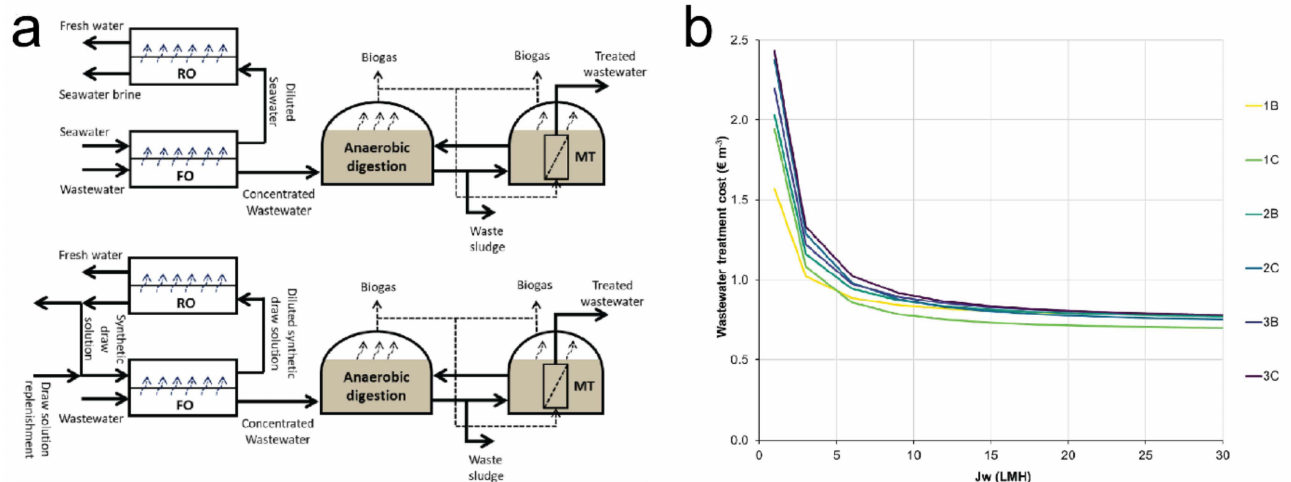
Figure 5. ( a ) Open-loop FO-RO-AnMBR system (top) and closed-loop FO-RO-AnMBR system (bottom), and ( b ) analysis of FO-RO-AnMBR cost in function to the FO membrane water flux, adapted with permission from